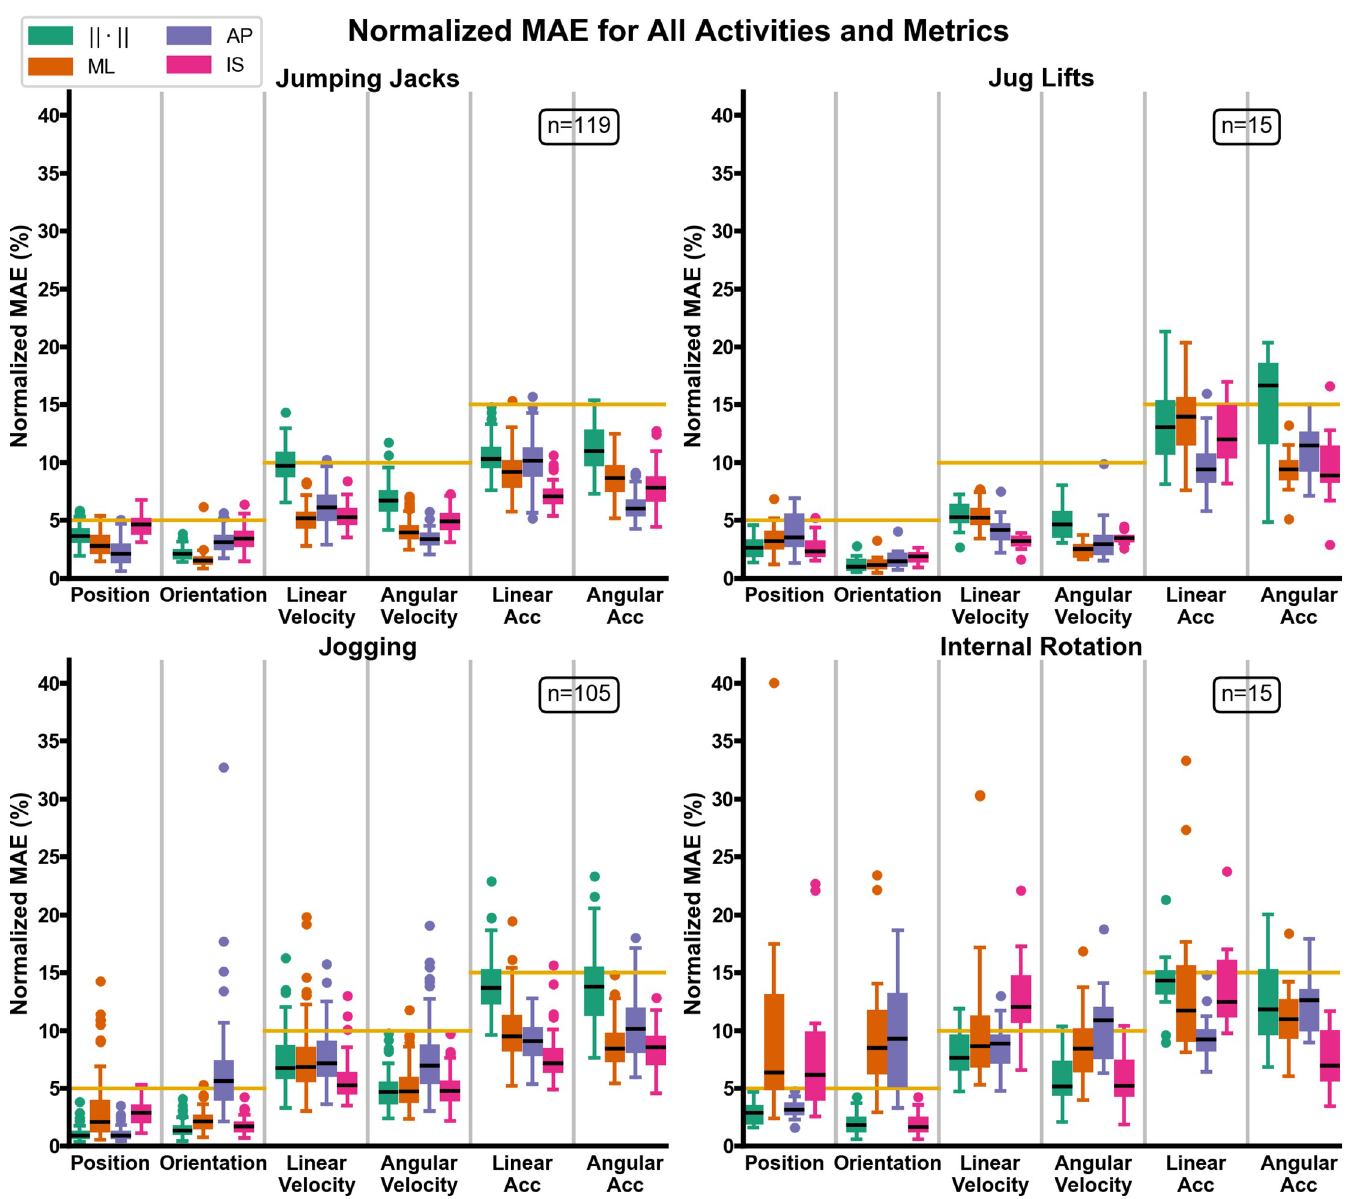
Fig 5. Boxplots of normalized MAE for all activities and metrics. For each activity and kinematic variable, the normalized MAE in the mediolateral (ML), anterior- posterior (AP), and inferior-superior (IS) direction of the thorax is presented. The normalized MAE of the magnitude of each kinematic variable is also presented and denoted via the Euclidean norm ( k�k ). Gold bars represent the cutoff values proposed as acceptable limits of robotic simulation error.